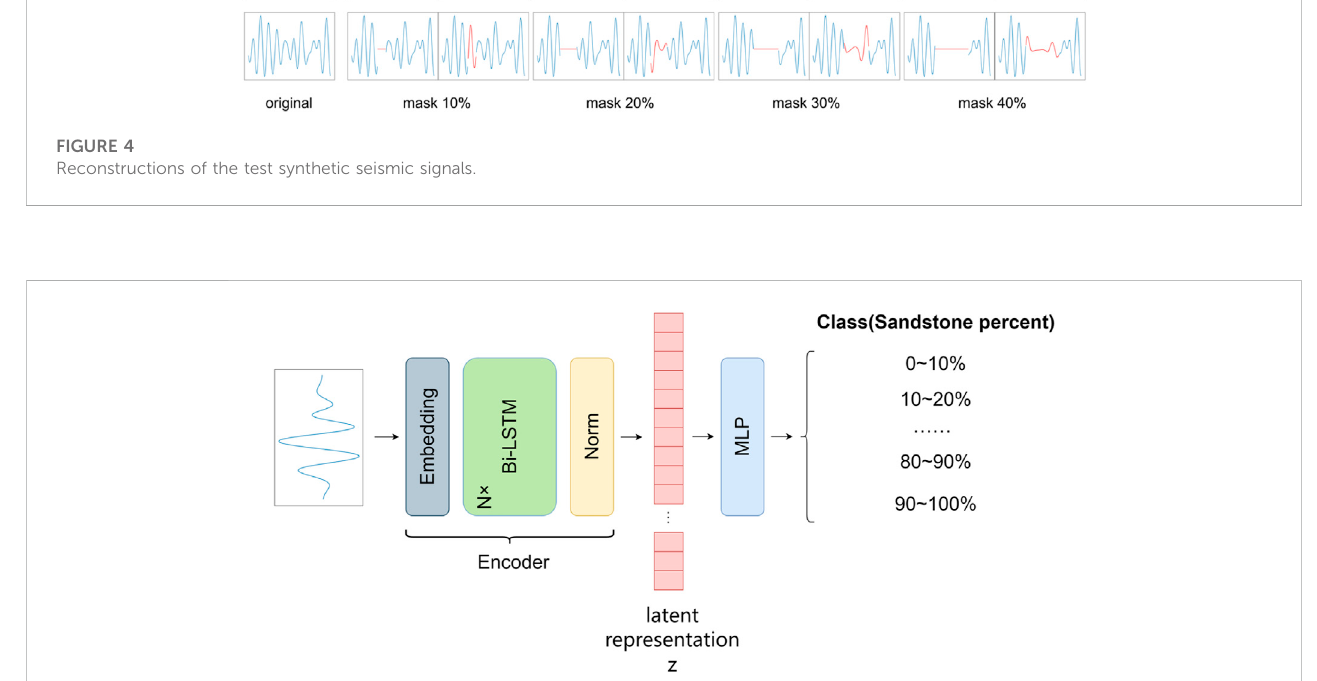
FIGURE 5 Overview of the fi ne-tuning network.